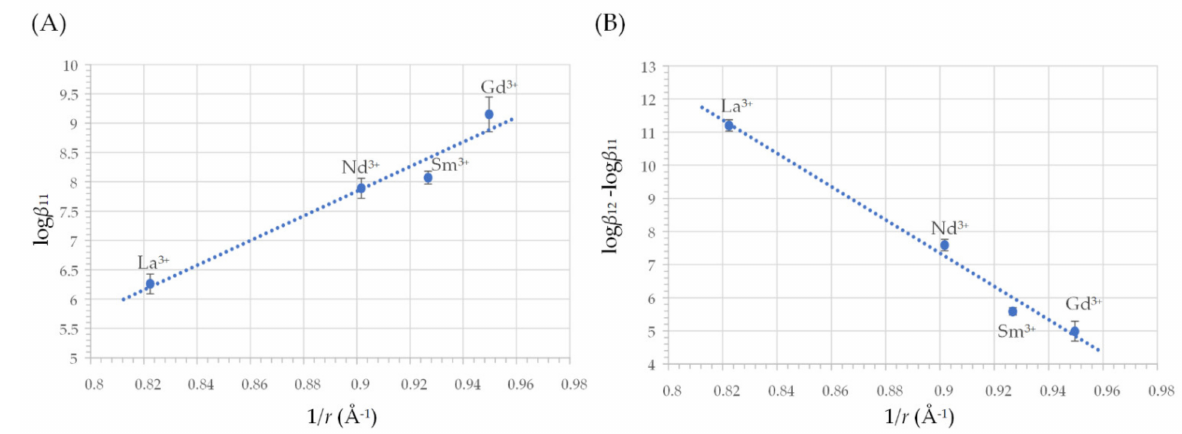
Figure 4. Correlation of formation constants from Table 3 with the radius (i.e., r ) of Ln 3+ cations: La 3+ ( r = 1.216 Å), Nd 3+ ( r = 1.109 Å), Sm 3+ ( r = 1.079 Å), Gd 3+ ( r = 1.053 Å) [43]: ( A ) equilibrium constant ( β 11 ) for reaction Ln 3+ + L 2 − (cid:10) LnL + ; ( B ) equilibrium constant ( K 12 = β 12 / β 11 ) for reaction LnL + + L 2 − (cid:10) LnL 2 − . L 2 − = (harzianic acid) 2 − . Dotted lines are least squares regression lines, and error bars represent three times the estimated standard deviation (3 σ ).